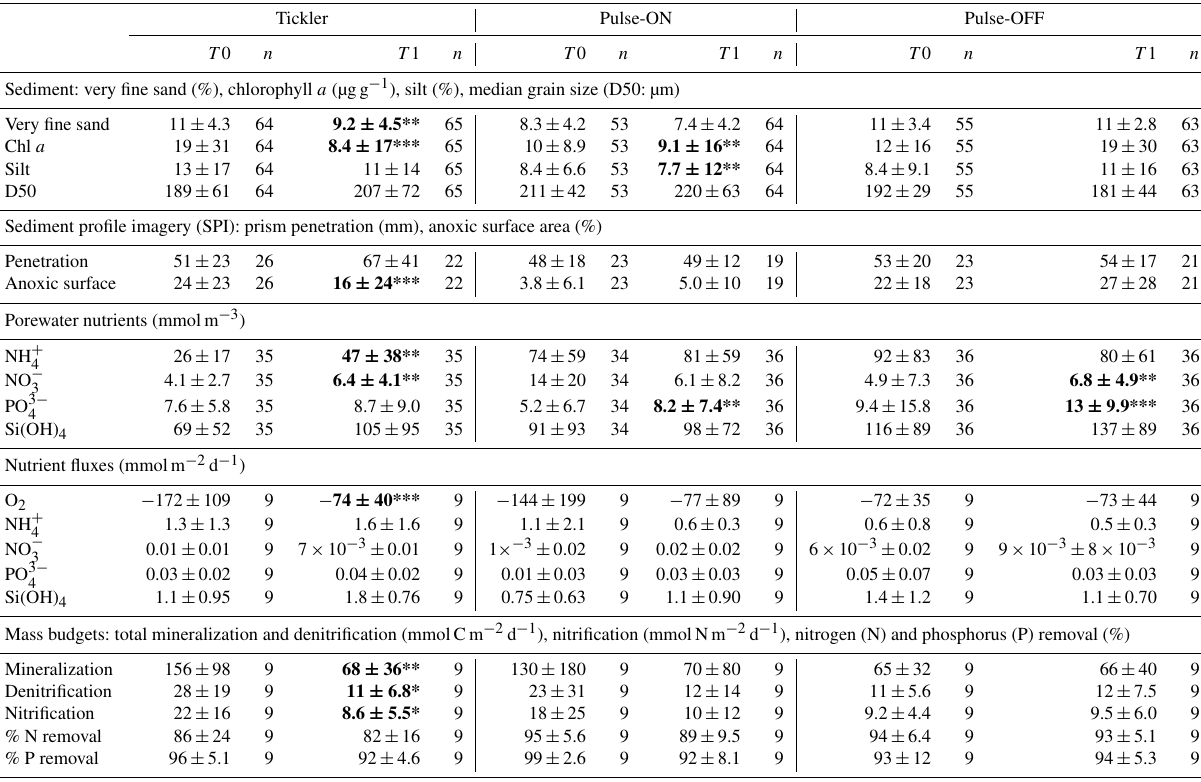
Table 1. Results for sediment and biogeochemical parameters between T 0 and T 1 for Tickler, Pulse-ON, and Pulse-OFF treatments (mean ± SD). Nitrogen (N) and phosphorus (P) removal are presented as the percentage of inorganic N or P removed from the sediments after being formed from organic matter mineralization. Tickler Pulse-ON